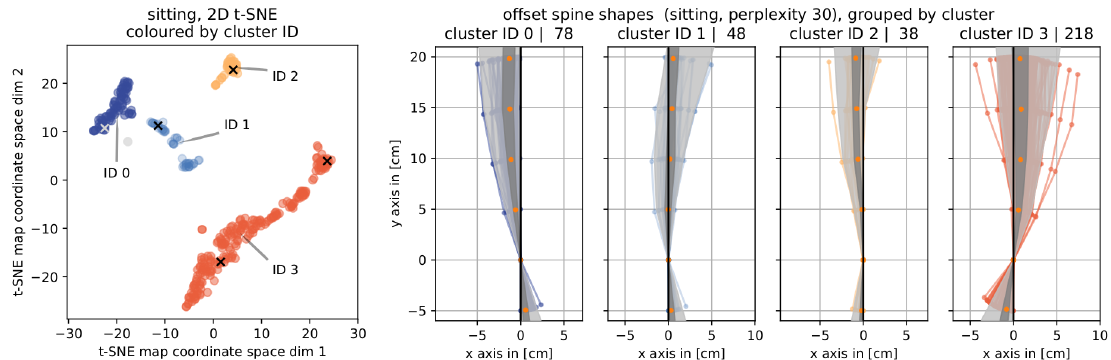
Figure A3. Results for clustering posture pairs of sitting . ( left ) The t-SNE map colored by cluster ID. An ‘x’ marks the position of a cluster representative. ( right ) Corresponding cluster bundles of offset spine shapes